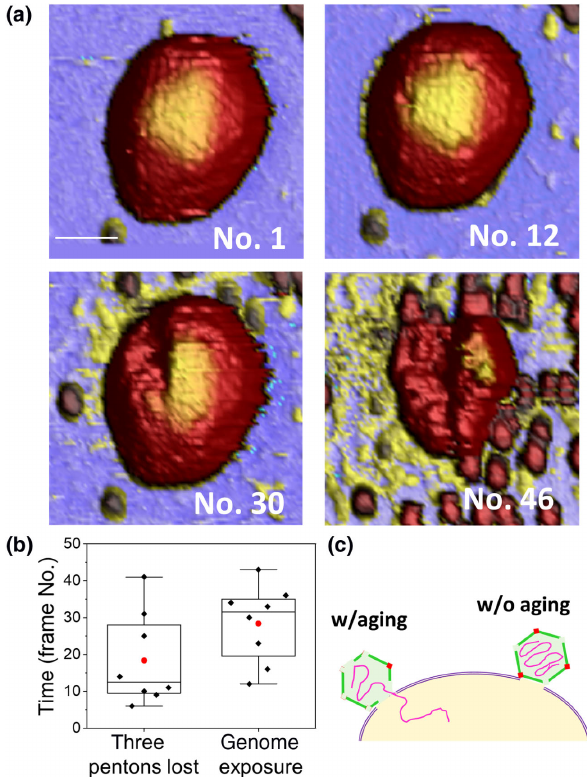
FIG. 4. Genome exposure and cooperative penton release. (a) Top-left panel: intact virus particle (scale bar corresponds to 40 nm). Top-right panel: the same particle with three penton vacancies at frame No. 12. Bottom-left panel: the same particle at frame No. 30, showing some DNA released. Bottom-right panel: the final state of the collapsed particle. (b) Chart presenting the number of frames required for releasing the pentons and inducing DNA exposure. (c) Model of viral-impaired uncoating at the nuclear pore assuming aging (left) and nonaging (right) penton